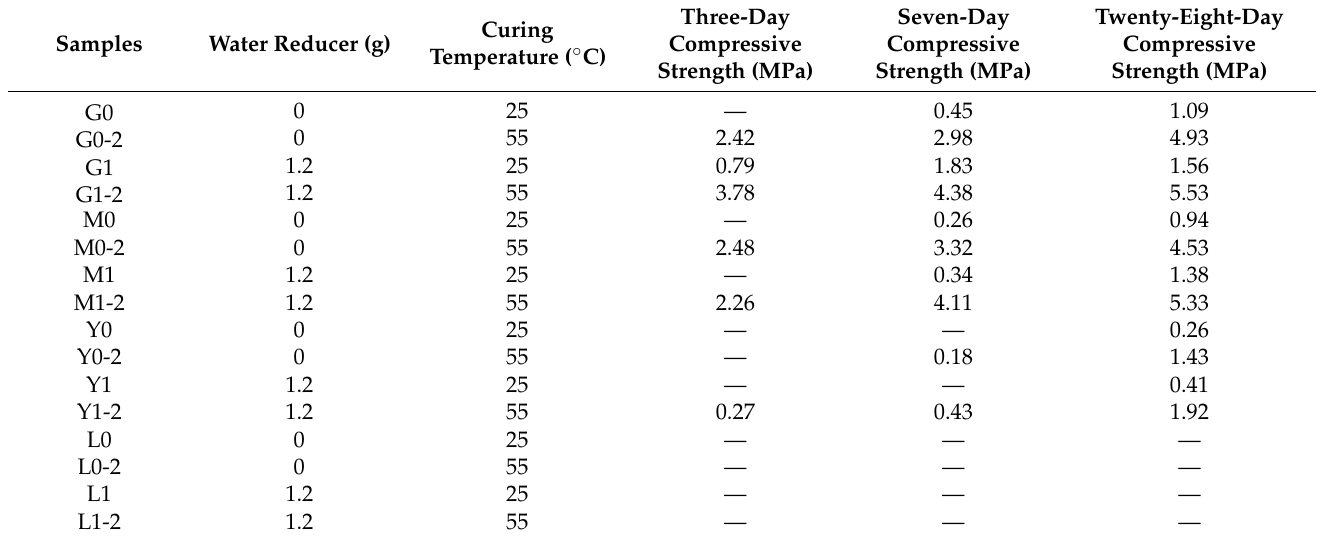
Figure 1. Results of 3-, 7- and 27-day compressive strength of samples: ( a ) group G, ( b ) group M, ( c ) group Y. Table 1. Compressive strength of samples at different ages.